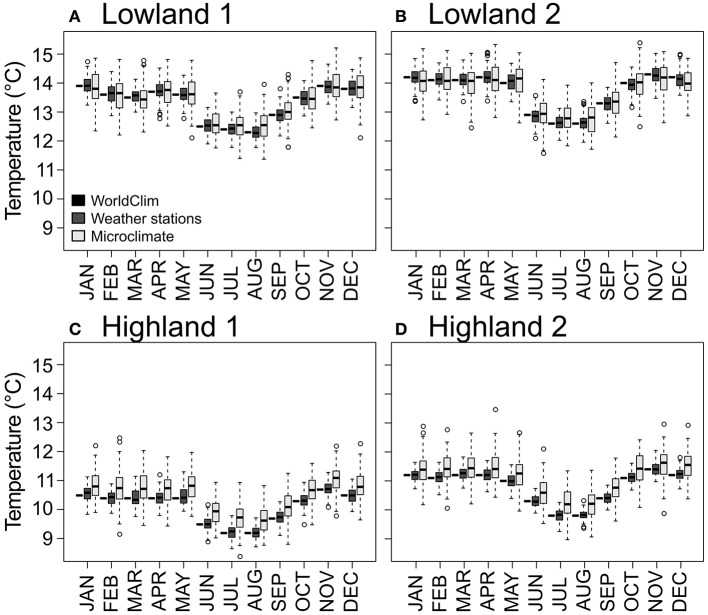
Standardized temperatures for each month and each dataset. The WorldClim dataset is represented as black horizontal bars. The Weather stations and Microclimate datasets are represented as dark gray and light gray boxplots, respectively. Panels (A–D) for the four study sites.